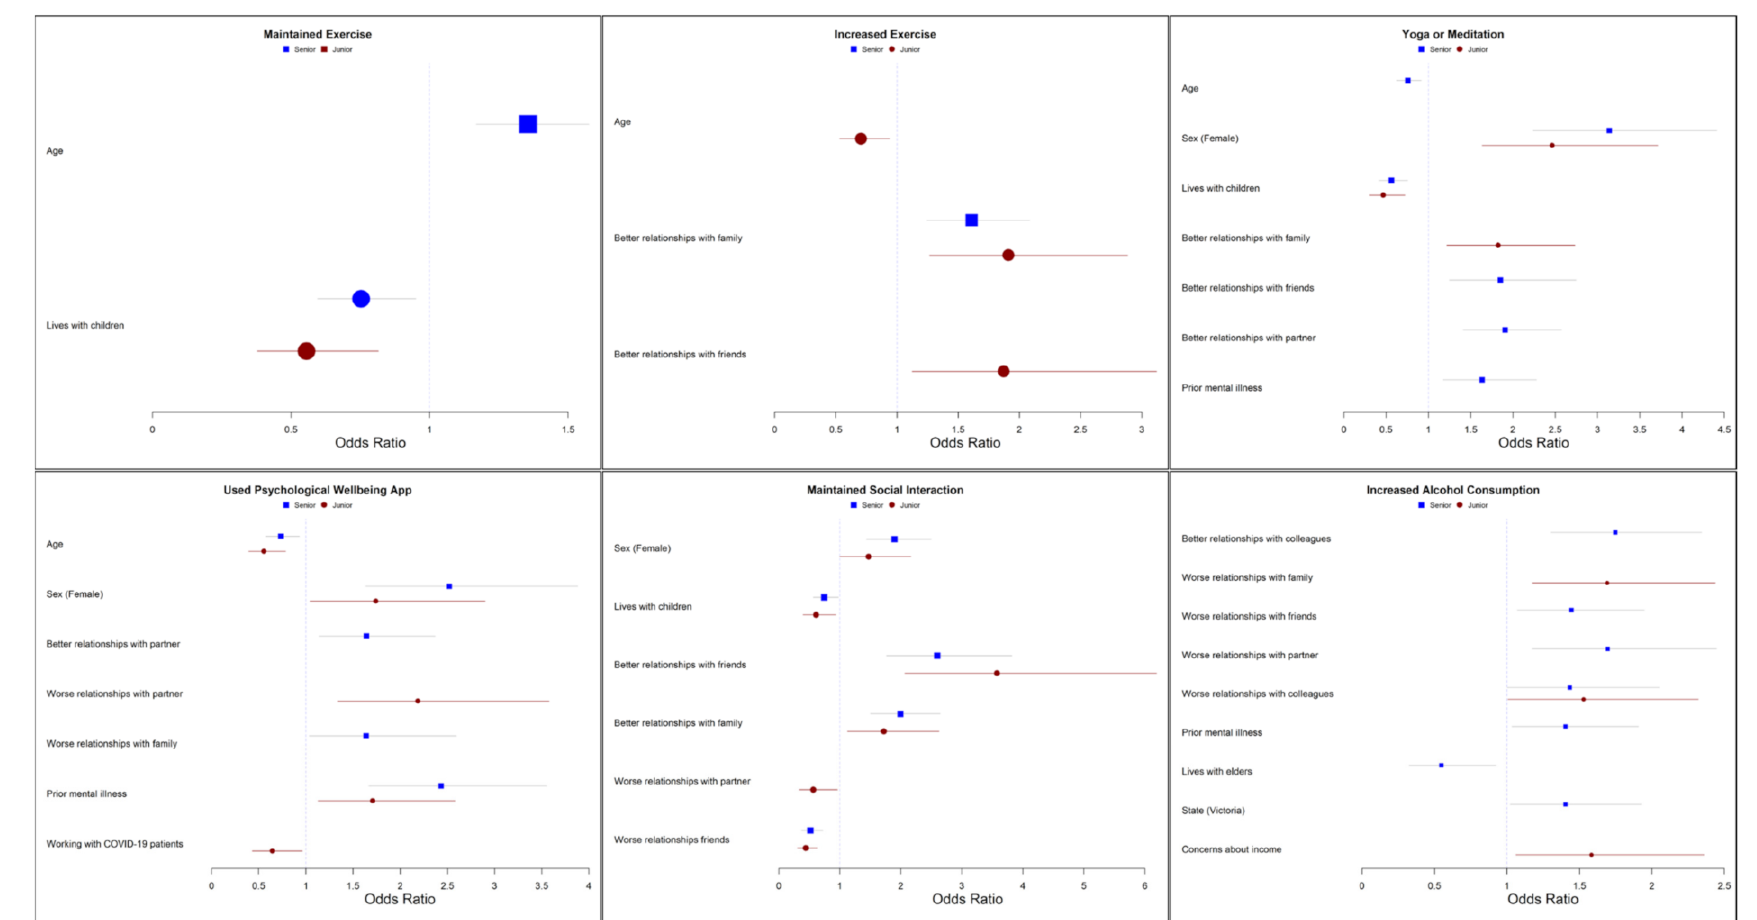
Figure 1. Personal and workplace predictors of coping strategies used by junior and senior medical staff. Red circles = junior, blue squares = seniors. Lines represent odds ratio and 95% confidence intervals. Reference categories: age (ordinal), female vs. male, Victoria vs. all other states, lives alone vs. with others, children vs. none, elderly care vs. none, worse relationships vs. neutral, better relationships vs. neutral, prior mental health diagnosis vs. none, concerns about income vs. negative response, family or friend infected with COVID-19 vs. negative